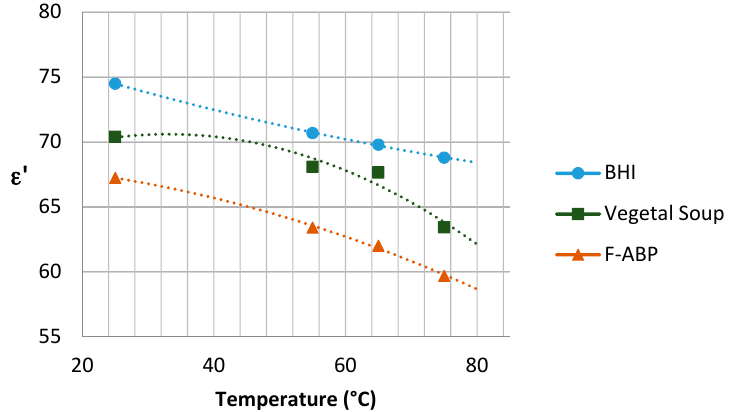
Figure 5. Dielectric constant for the samples under study near 2.45 GHz.